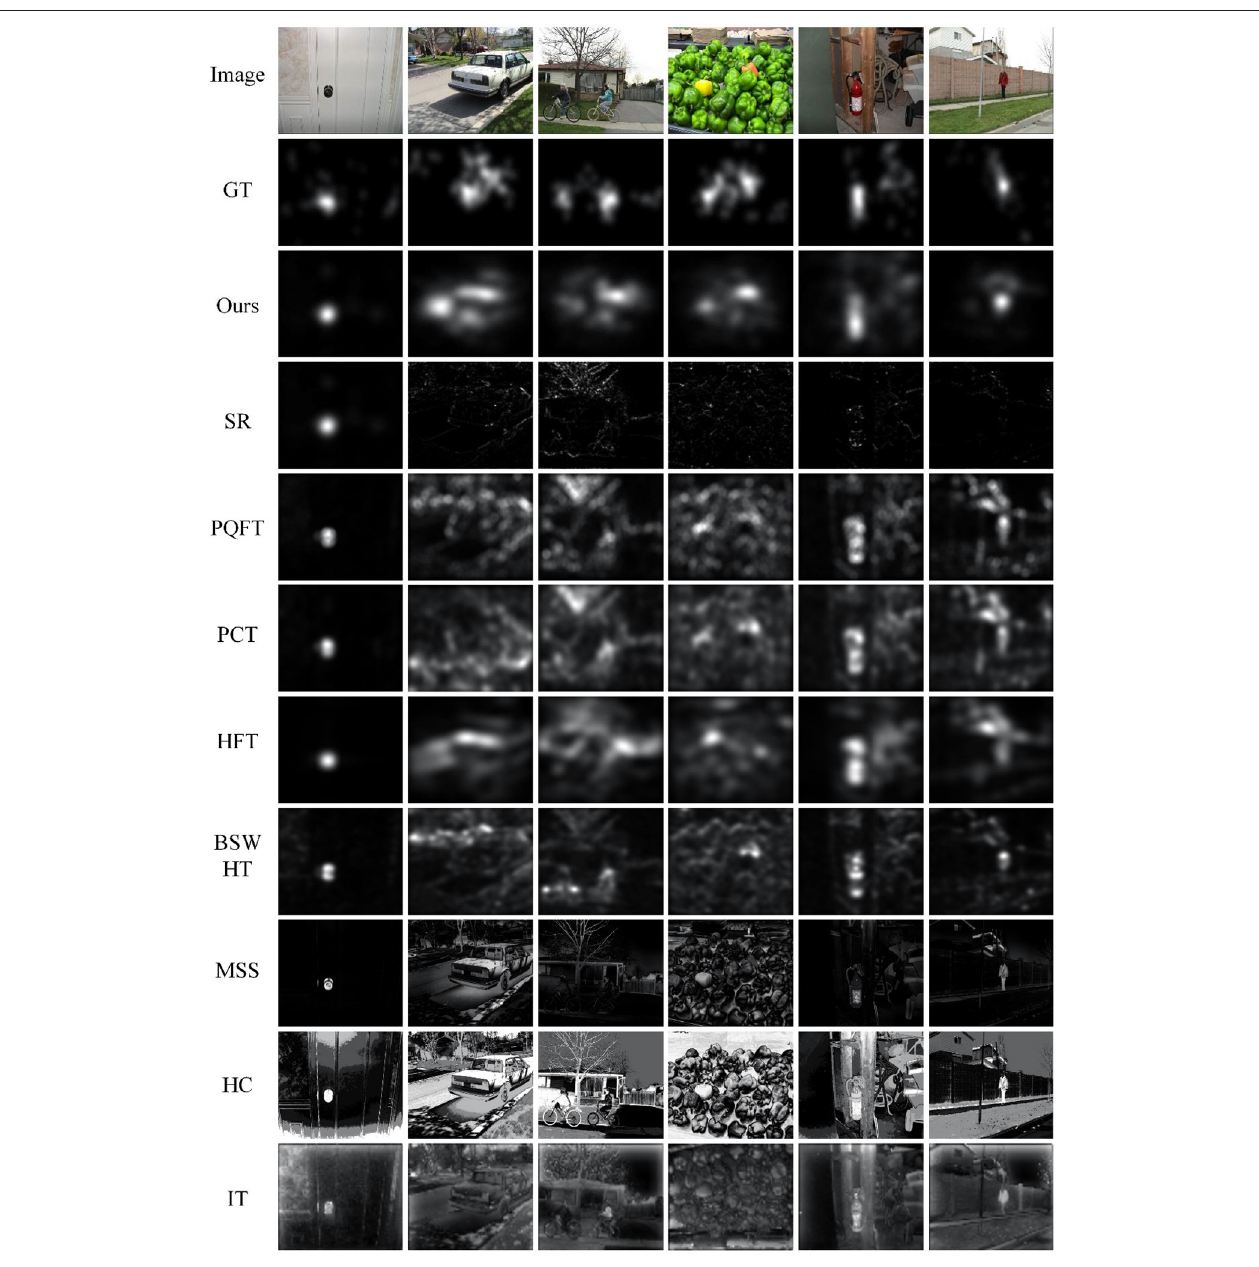
FIGURE 3 | Qualitative analysis of the saliency maps for eye fixation